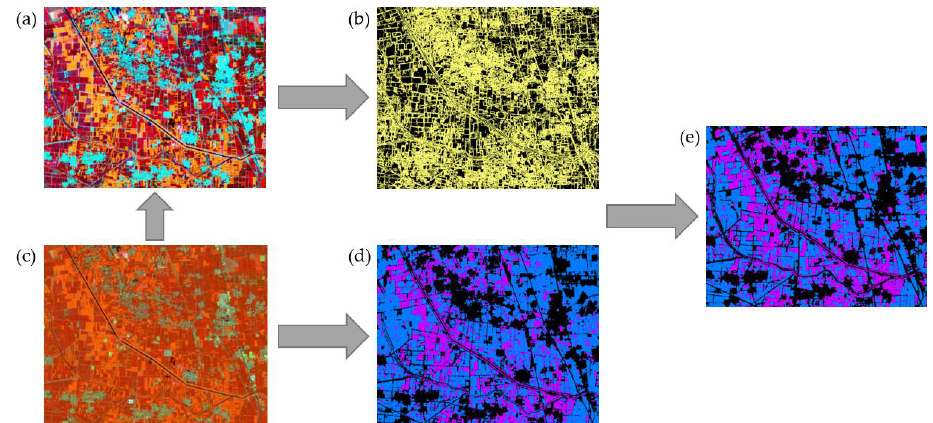
Figure 9. Schematic of the superpixel optimization process. ( a ) Enhanced Band 8, Band 11, Band 4 false color image. ( b ) SLIC extraction results. ( c ) Band 8, Band 11, Band 4 false color synthesis of the Sentinel-2 image. ( d ) Classified result. ( e ) Optimized